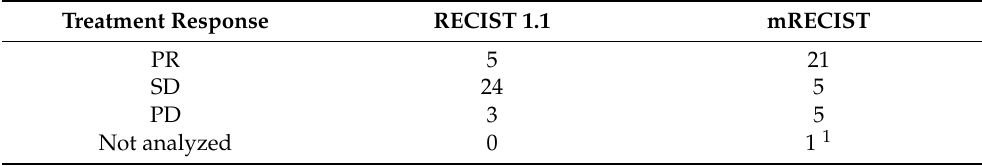
Table 4. Distribution of treatment response on first follow-up by RECIST 1.1 and